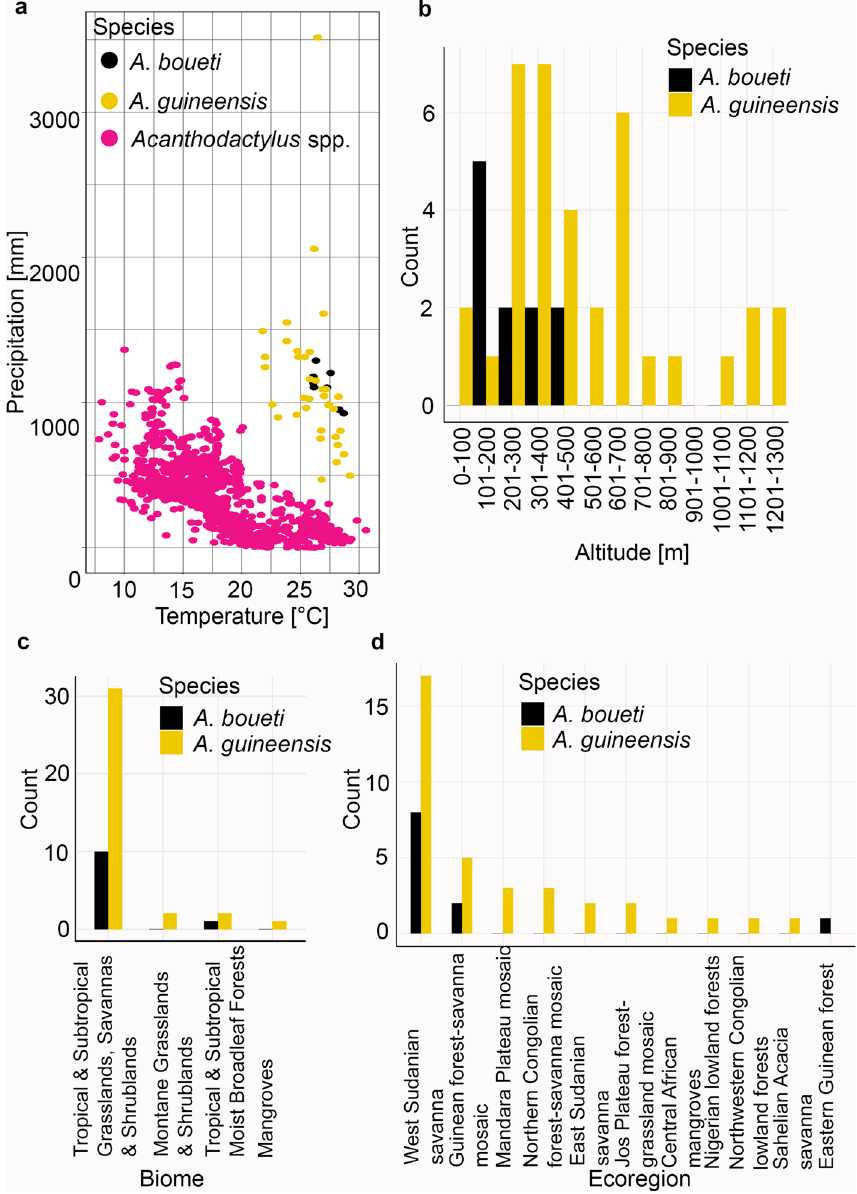
Figure 4. ( a – d ) Environmental niche and habitat of A. guineensis and A. boueti with respect to ( a ) mean annual temperature and precipitation in comparison to all other Acanthodactylus spp., ( b ) elevation, ( c ) inhabited biomes, and ( d )